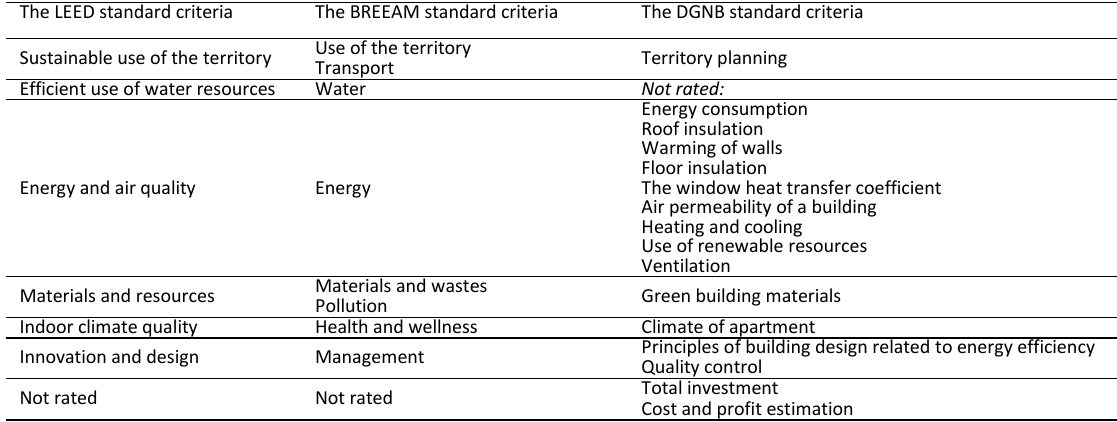
Table 1: Criteria for assessing a building by LEED, BREEAM and DGNB